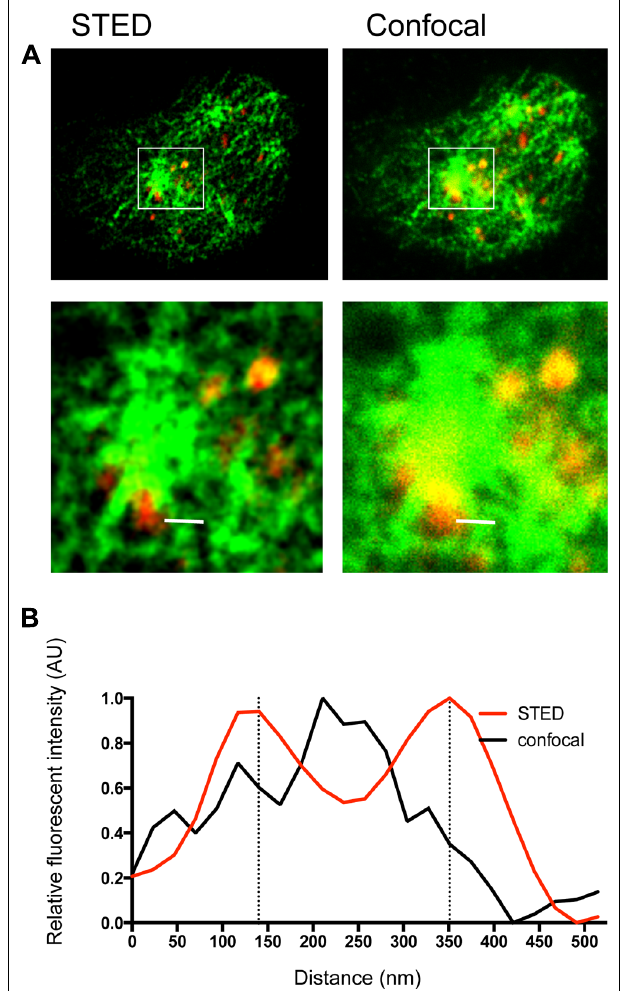
FIGURE 1 | Lytic granules on NK cell microtubules visualized by dual color STED nanoscopy and confocal microscopy. NK92 cells were activated on anti-CD18/-NKp30 coated glass as described previously (Rak etal., 2011). Cells were fixed, permeabilized and stained with tubulin biotin-streptavidinV500 (green) and perforin AlexaFluor 488 (red), then mounted with ProLong antifade. Cells were imaged on a LeicaTCS confocal microscope with 100 × 1.4 NA APO objective and gated STED module. Excitation was by white light laser and fluorescence emission was detected by HyD detectors. Images were acquired and processed with LASAF software (Leica). (A) A single NK cell imaged at the plane of glass is shown in dual channel STED ( left ) and confocal ( right ). A central region is enlarged to show detail ( bottom ). (B) A line profile taken across the white bar shown in (A) depicts relative fluorescence of tubulin staining (arbitrary units, AU) in confocal (black) and STED (red).To generate the line profile, TIFs were exported to ImageJ (NIH) and the line profile function was used to generate raw data, which was then exported to GraphPad Prism (GraphPad Software), normalized, and